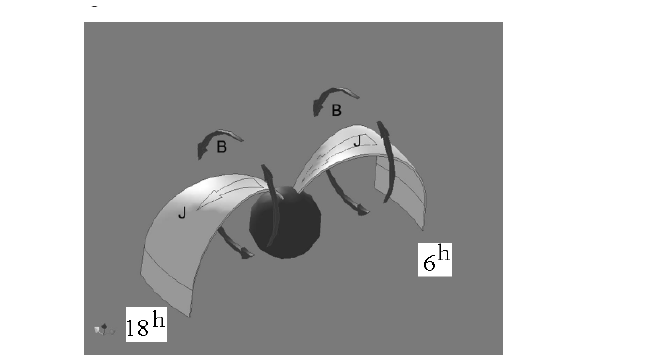
Fig. 2. Magnetic field B tcs caused by the Region 1 current sheets, J , flowing into the ionosphere in dawn and flowing out of the iono- sphere in dusk. The field B tcs is southward at noon and northward at